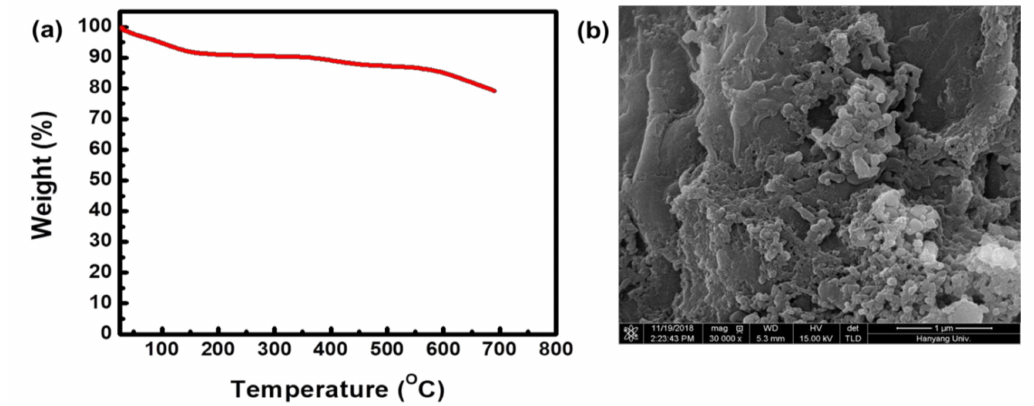
Figure 3. ( a ) Thermogravimetric analysis of CPP-P2; ( b ) FESEM of